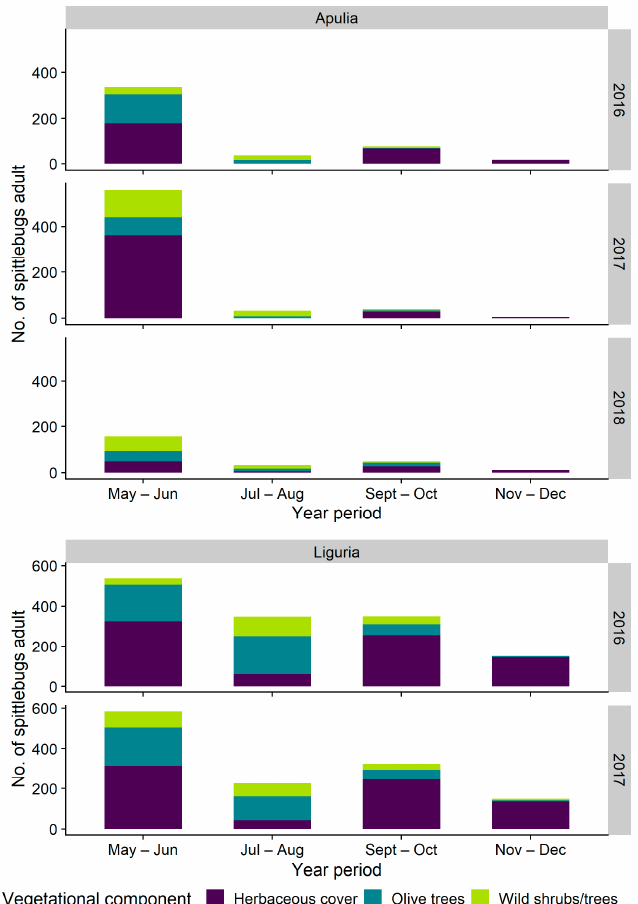
Figure 9. Abundance of Philaenus spumarius adults on different vegetational components in Apulia and Liguria olive groves throughout the year.